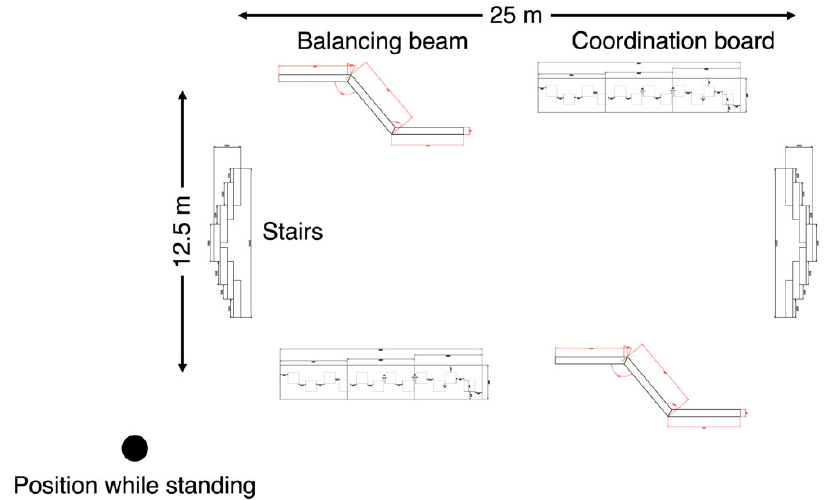
Figure 1. Layout of the obstacle course. The obstacle course consisted of two staircases, two balancing beams, and two balancing boards with cut-out foot-holes, spanning an overall perimeter of 75 m. Participants had to either stand at the position of the dot, walk around the obstacle course, or walk while traversing the obstacle course elements. When performing locomotion conditions, walking direction was counter-balanced between clockwise and anti-clockwise direction.